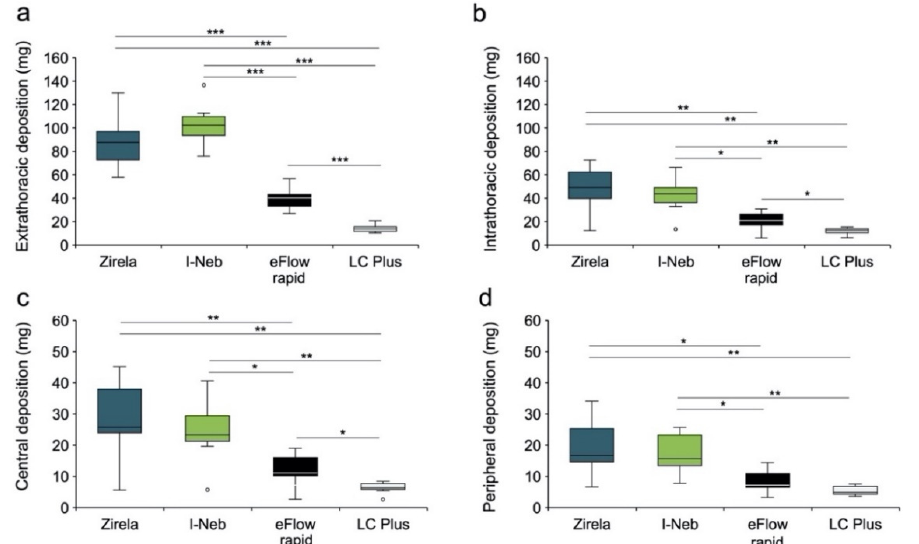
Figure 4. Levofloxacin lung deposition from functional respiratory imaging simulations. Mean ( a ) extrathoracic, ( b ) intrathoracic, ( c ) central, and ( d ) peripheral deposition for each nebuliser. Box plots show the lower quartile, median, and upper quartile, and the whiskers indicate the maximum and minimum values excluding outliers (outliers: values 3/2 times higher or lower than the upper or lower quartiles). * p < 0.05, ** p < 0.01, *** p < 0.0001.